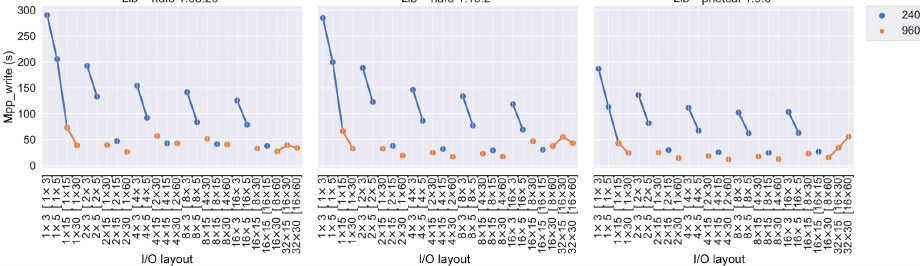
Figure 5. mpp_write time versus I / O layout for different library and PE numbers. Write time improves greatly as I / O nodes are increased (grouped curves) and modestly as the I / O PEs per node are increased (across grouped curves). Runtimes are scalarly reduced as PEs are increased. PnetCDF shows modest improvement over HDF5 performance. The I / O layout together with its PE distribution in [PE per node × nodes] are labelled on the x axis.